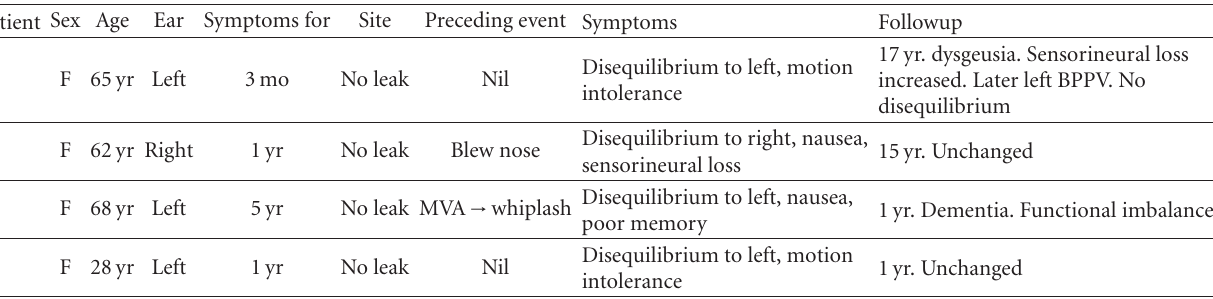
Table 2: Four patients with a negative exploration for PLF.